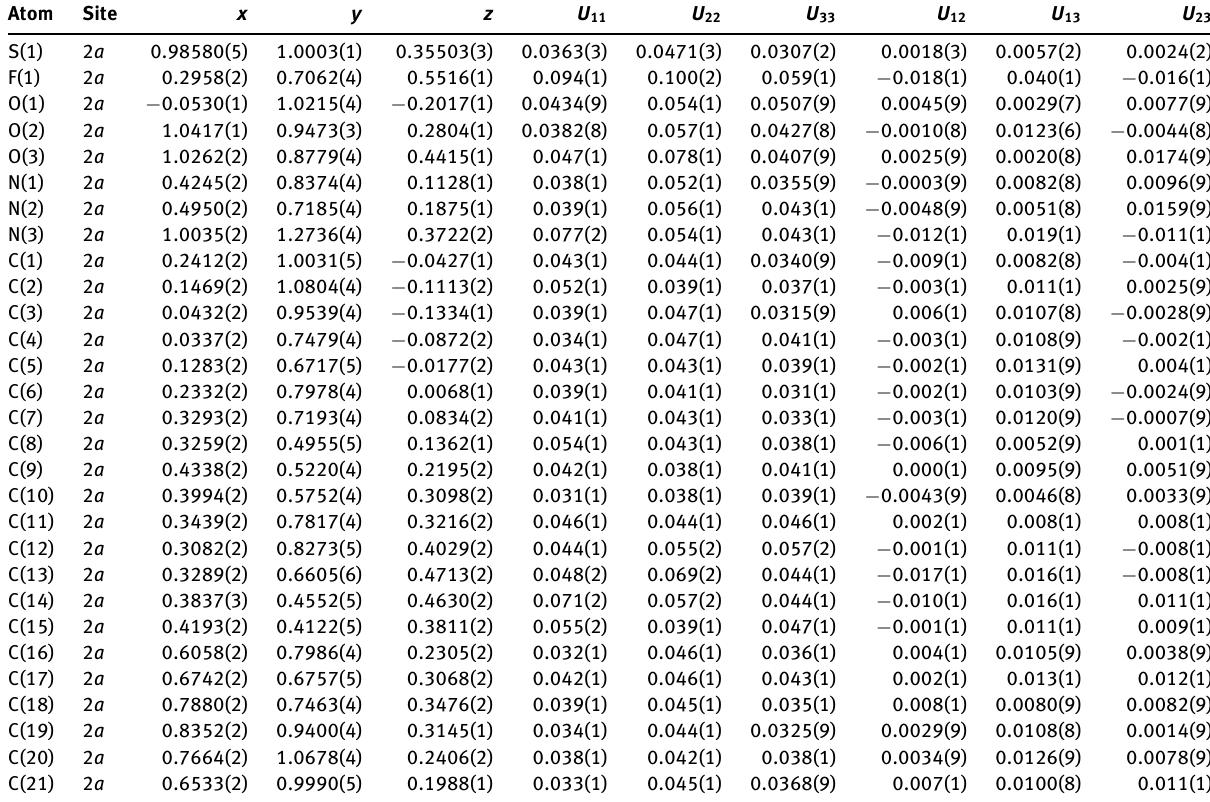
Table 3: Atomic coordinates and displacement parameters (in Å 2